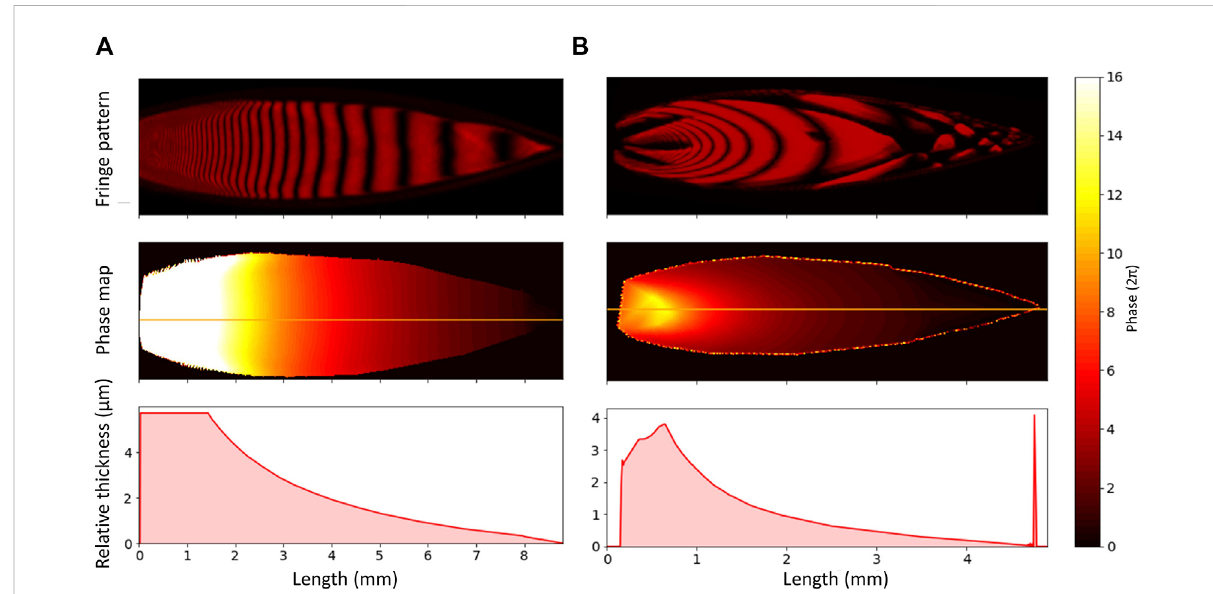
Monochromatic interferograms producedby illuminating isopropanol with a633 nm HeNe laser. (A) uses the fanspraynozzle, and (B) uses the Micronit nozzle. Below the fringe patterns are some phase maps, produced from the fringe patterns using Jakub Dranczewski ’ s Magic2 package (Dranczewski, 2021). The bottom panel shows the change in relative thickness along the centerline of the sheet, indicated on the phase map. The phase near the nozzle becomes unreliable due to the fact that the lines become so close together that the camera cannot resolve them properly. In reality, the thickness should continue to increase smoothly. The spike in the thickness pro fi le in column (B) is an artefact due to light scatter from the rim of the sheet.